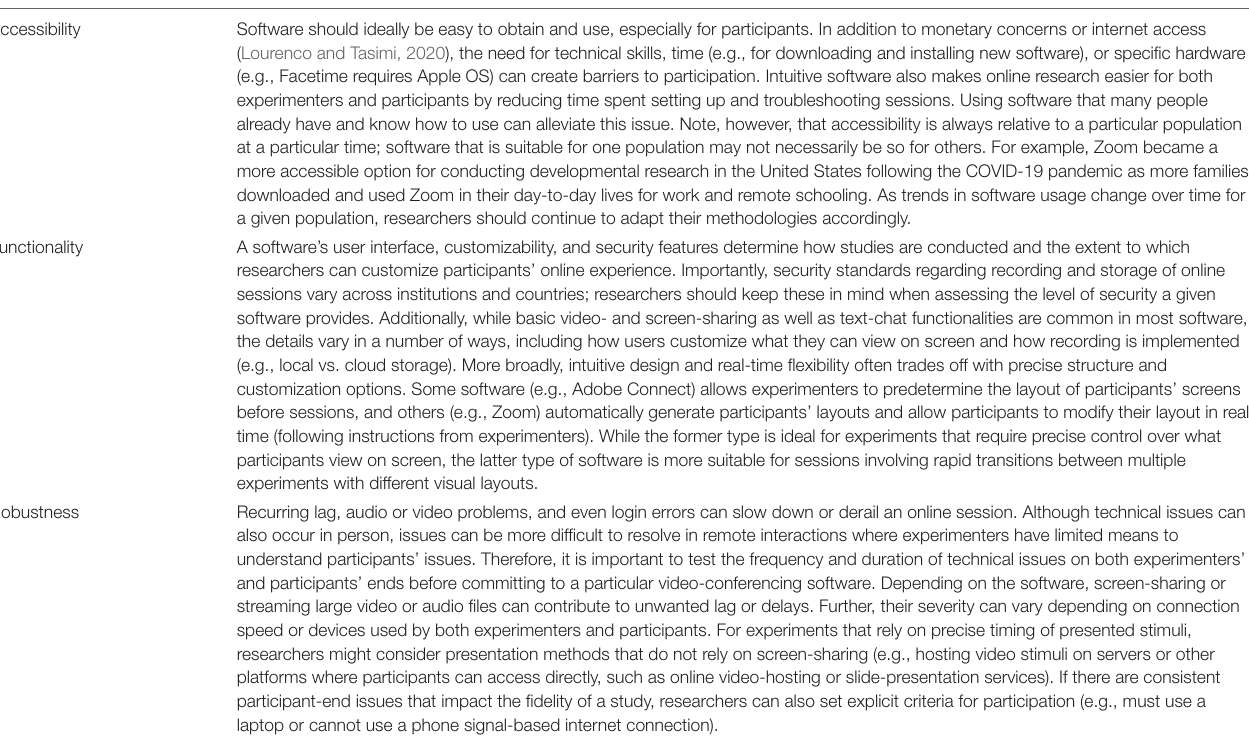
TABLE 1 | Factors to consider when choosing software for moderated online data collection.